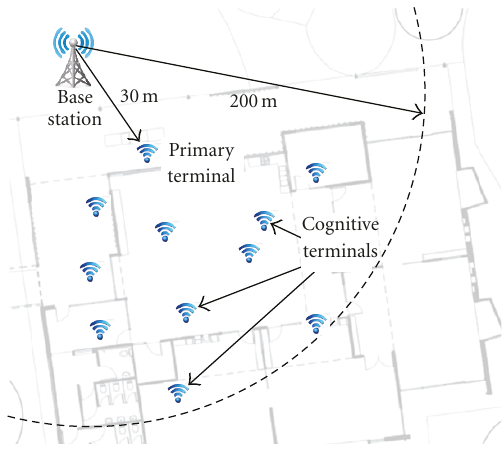
Figure 9: The outdoor-to-indoor scenario.